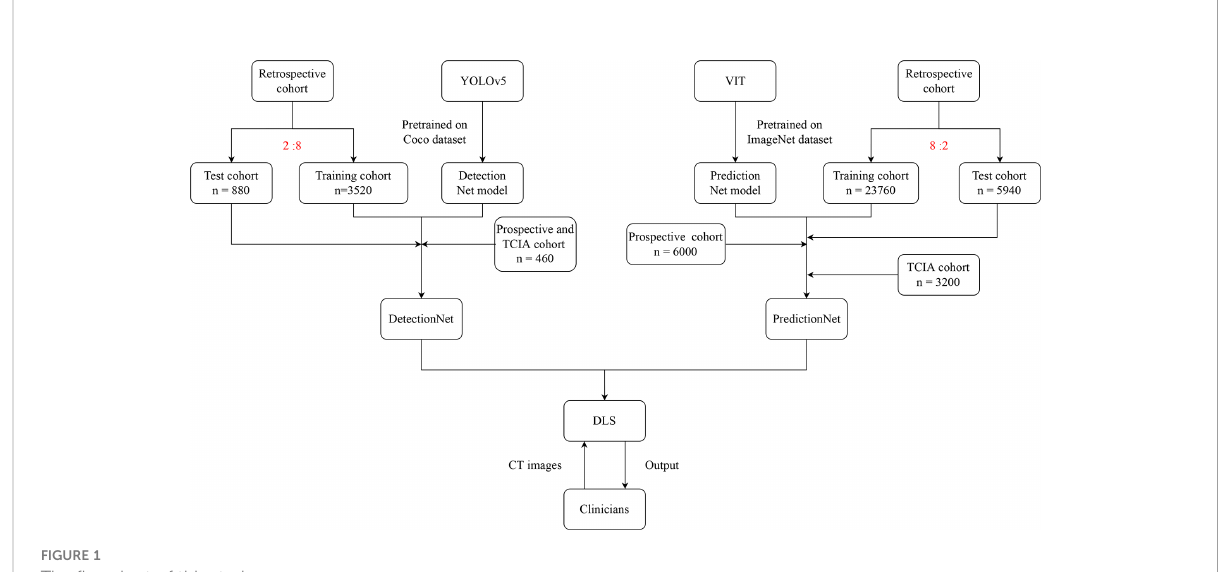
FIGURE 1 The fl owchart of this